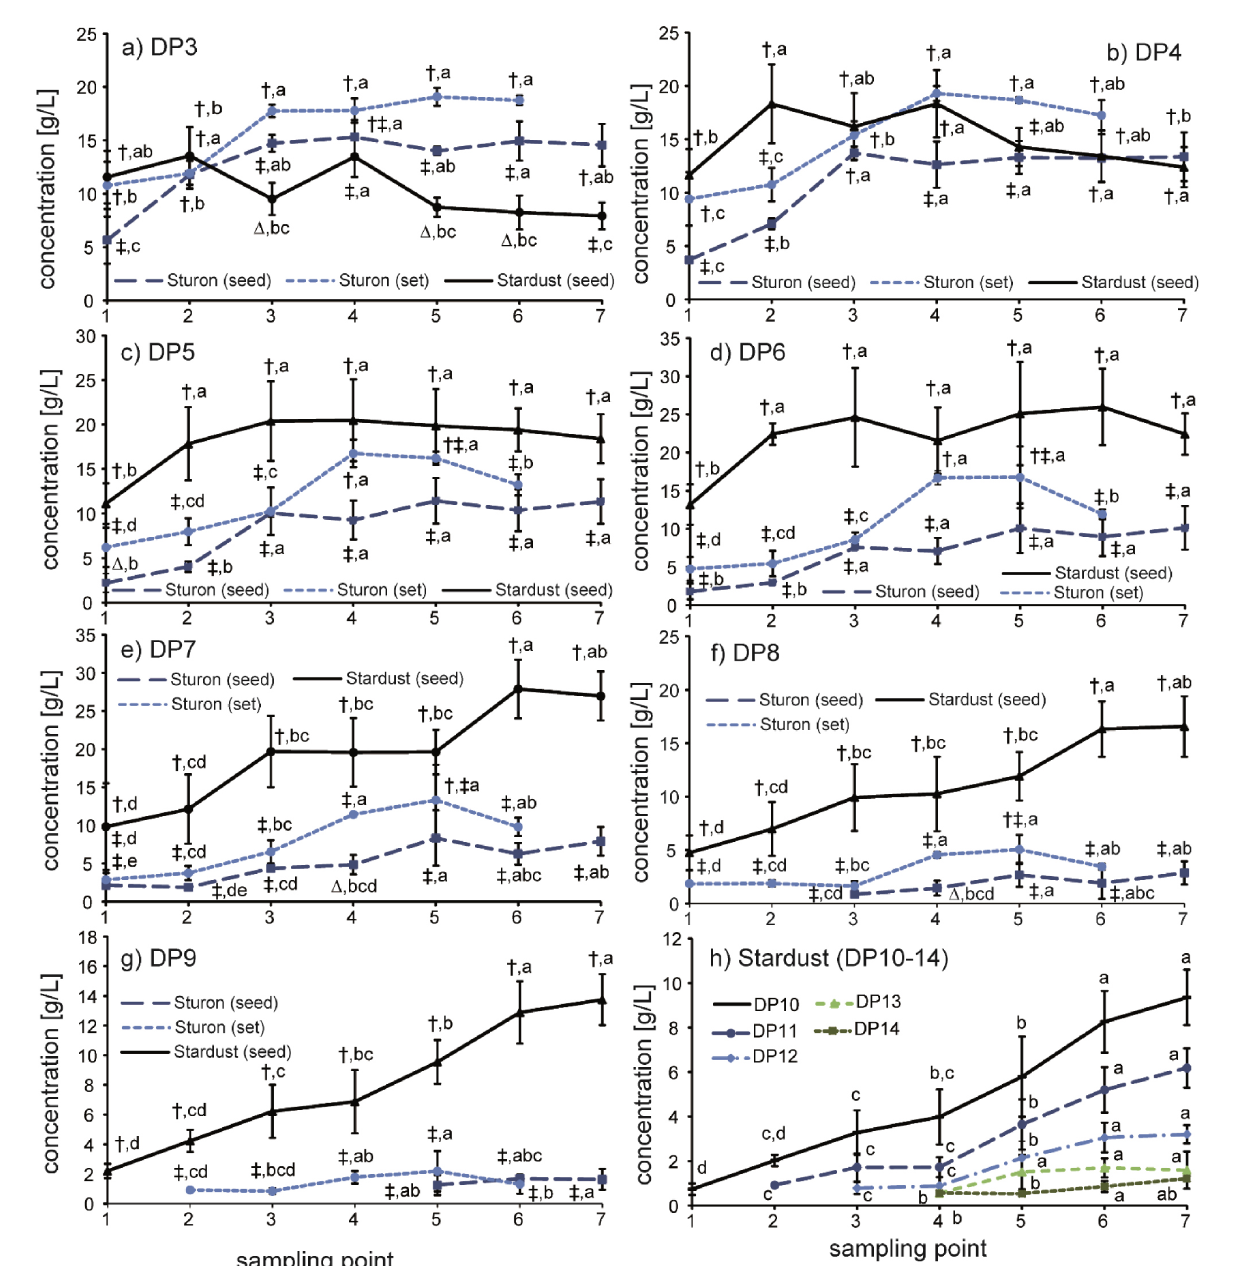
Fig. 3: Concentration of fructooligosaccharides (FOS) with a degree of polymerization (DP) between 3 and 9 (a - g) in different stages of maturity in onions of the cultivars ‘Sturon’ (grown from sets), ‘Sturon’ (grown from seeds) and ‘Stardust’ (grown from seeds) and higher polymerized FOS (DP 10 to 14; h) in the cv. ‘Stardust’. Sampling point 1 represents the time point when first signs of bulb development were observed. Subsequent time points represent weekly sampling intervals, continued until leaves had fallen, i.e. until regular harvest of onions. On each sampling date, samples of five maturing onion bulbs were collected from 3 parcels per variant, i.e. 15 bulbs per sampling date and variant. Symbols †, ‡ and ∆ indicate significant differences of means ( p < 0.05) between individual variants Sturon (grown from seeds), Sturon (grown from sets) and Stardust (grown from seeds) at different sampling points. Different letters (a, b, c, d) indicate significant differences of means ( p < 0.05) within individual variants, sampled at different stages of